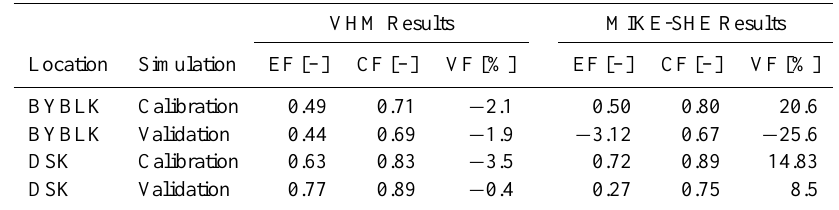
Table 1. Model performance evaluation statistics for BYBLK and DSK flow gauging stations, based on daily runoff results after model calibration and validation.